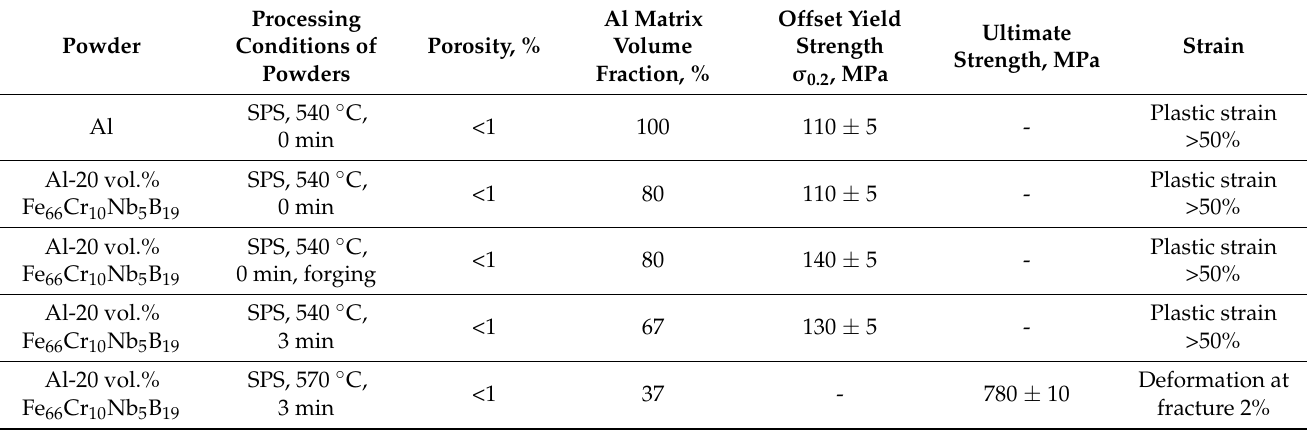
Table 1. Processing conditions, porosity, matrix content, and mechanical properties of composites obtained from the Al-Fe 66 Cr 10 Nb 5 B 19 powder mixture and sintered aluminum. Average values of the offset yield strength and ultimate strength are reported along with standard deviations.